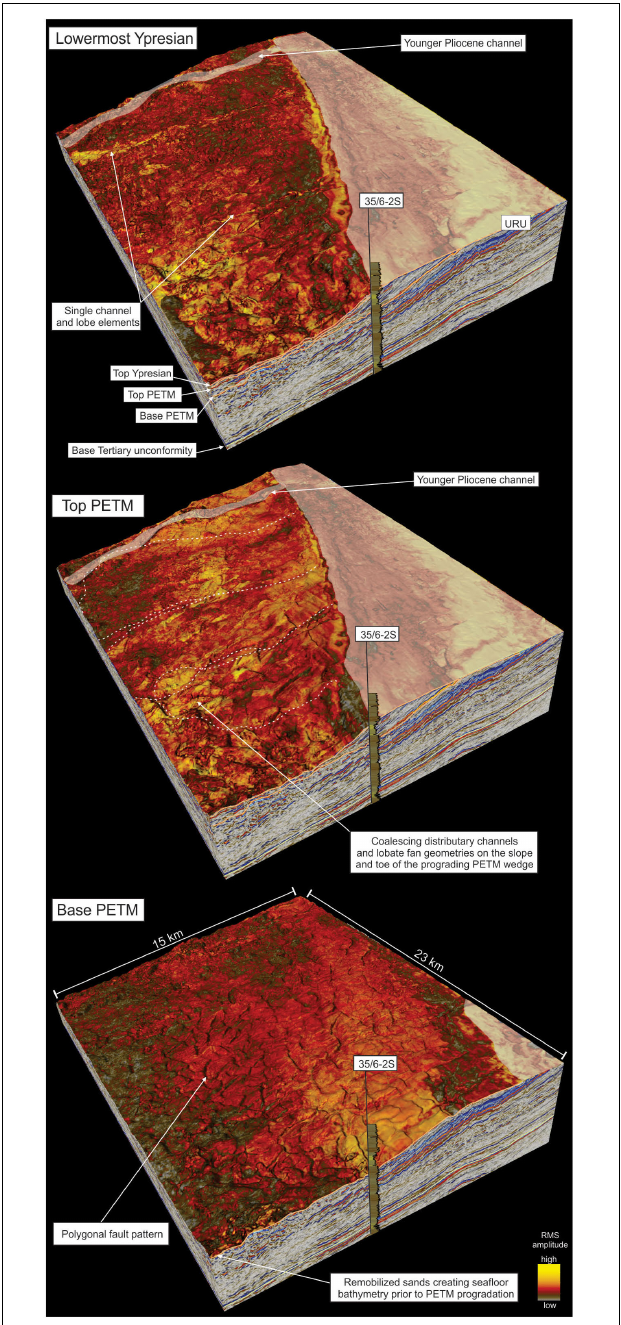
FIGURE 9 | Oblique view of co-blended root mean square (RMS) and variance attribute maps showing the evolution of the PETM wedge around and north of borehole 35/6-2S. The basal surface downlapped by the PETM wedge show polygonal fault pattern and little variation in amplitude, indicating fine-grained lithologies as shown in the borehole ( Figure 6 ). Near the top of the PETM wedge, high-amplitude channel and lobe geometries can be observed along strike of the prograding shelf-slope wedge, indicating sandy and more mixed lithologies. In 35/6-2S, this is recognized by a sand-dominated interval. Sand appears to have been shed into the area also after the PETM, but the amplitude maps show different geometries with more straight channels and smaller terminal lobes. See Figure 7 for